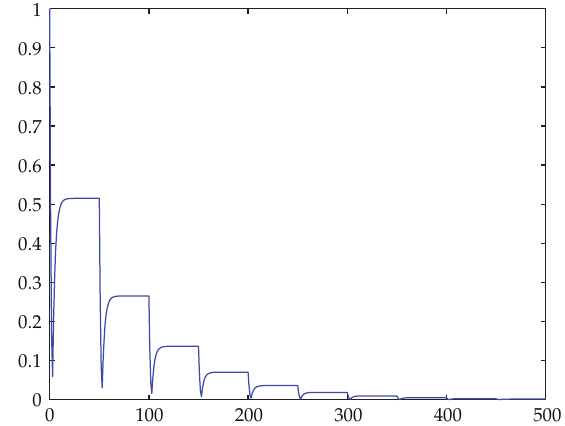
Figure 2: The Radau IIA collocation method with m (cid:4) 2 and p (cid:4) 100 for (cid:2) 7.1 (cid:3) .